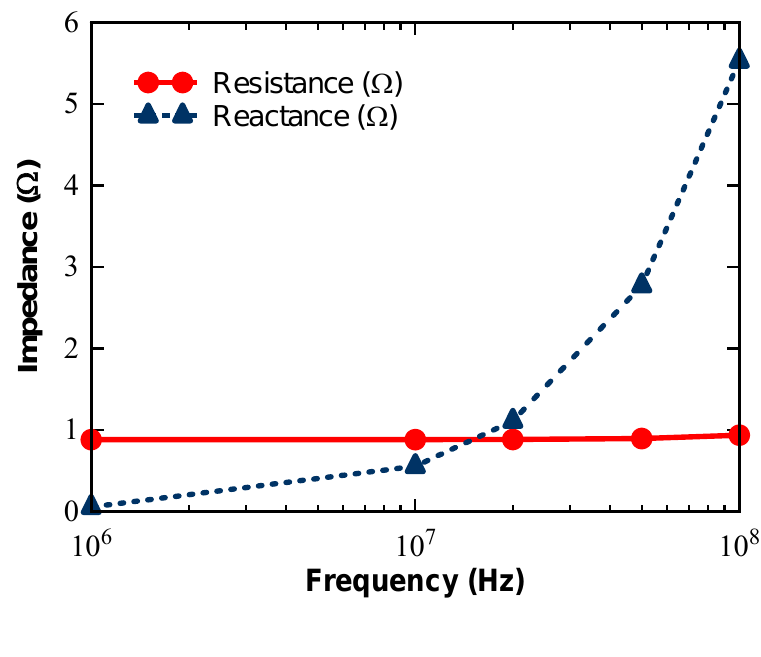
Figure 11. Impedance of A1/A2 bus lines vs.